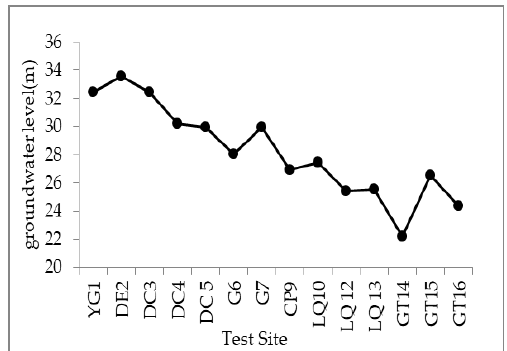
Figure 12. Groundwater level of sampling points.